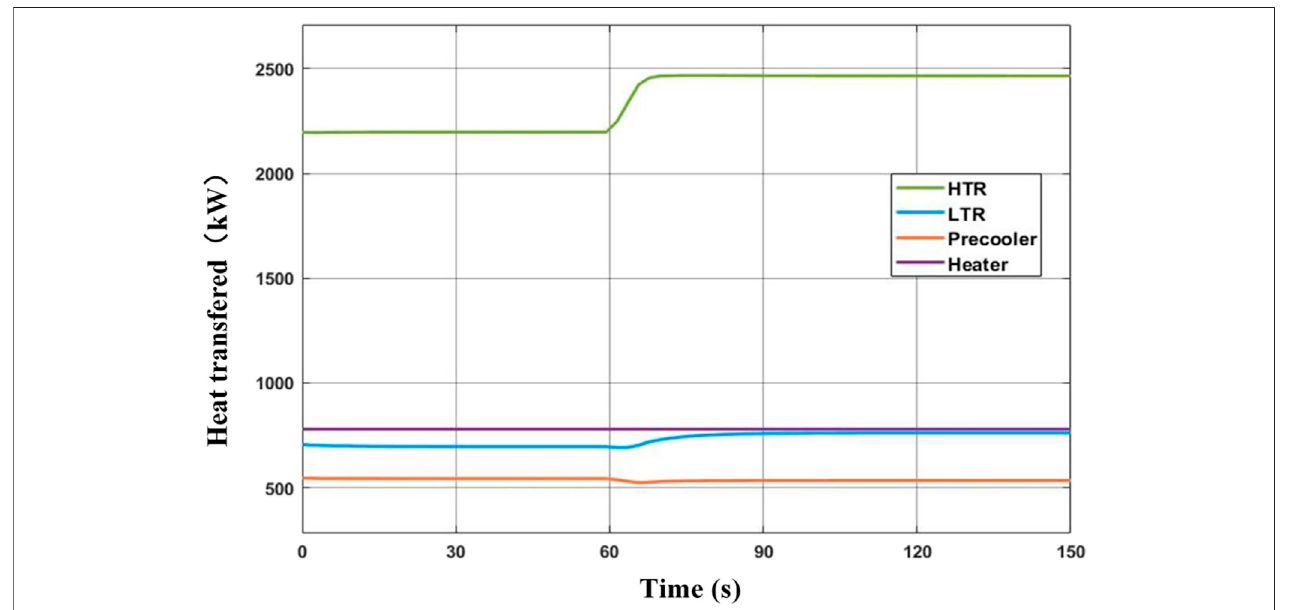
FIGURE 10 | Dynamic response of heat transfer in heat exchangers while reducing the cycle mass fl ow